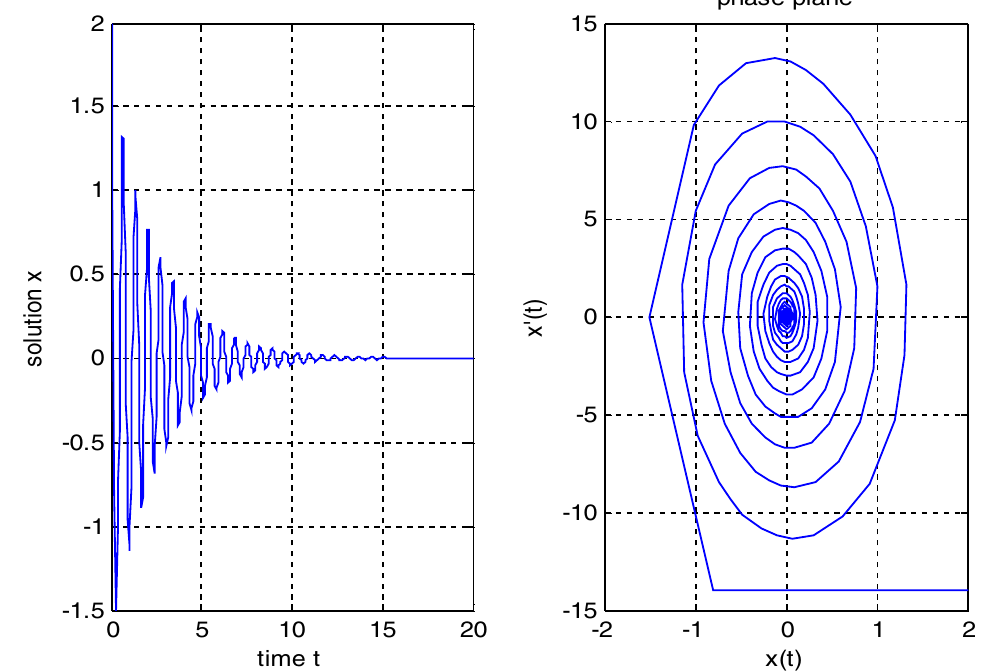
Figure 1. Delay differential equation dx dt